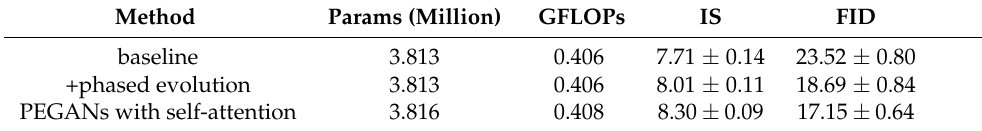
Table 3. The ablation experiments on CIFAR-10 (the data in the table are only for the generator). Method Params (Million) GFLOPs IS FID baseline 3.813 0.406 7.71 ± 0.14 23.52 ± 0.80 +phased evolution 3.813 0.406 8.01 ± 0.11 18.69 ± 0.84 PEGANs with self-attention 3.816 0.408 8.30 ± 0.09 17.15 ±